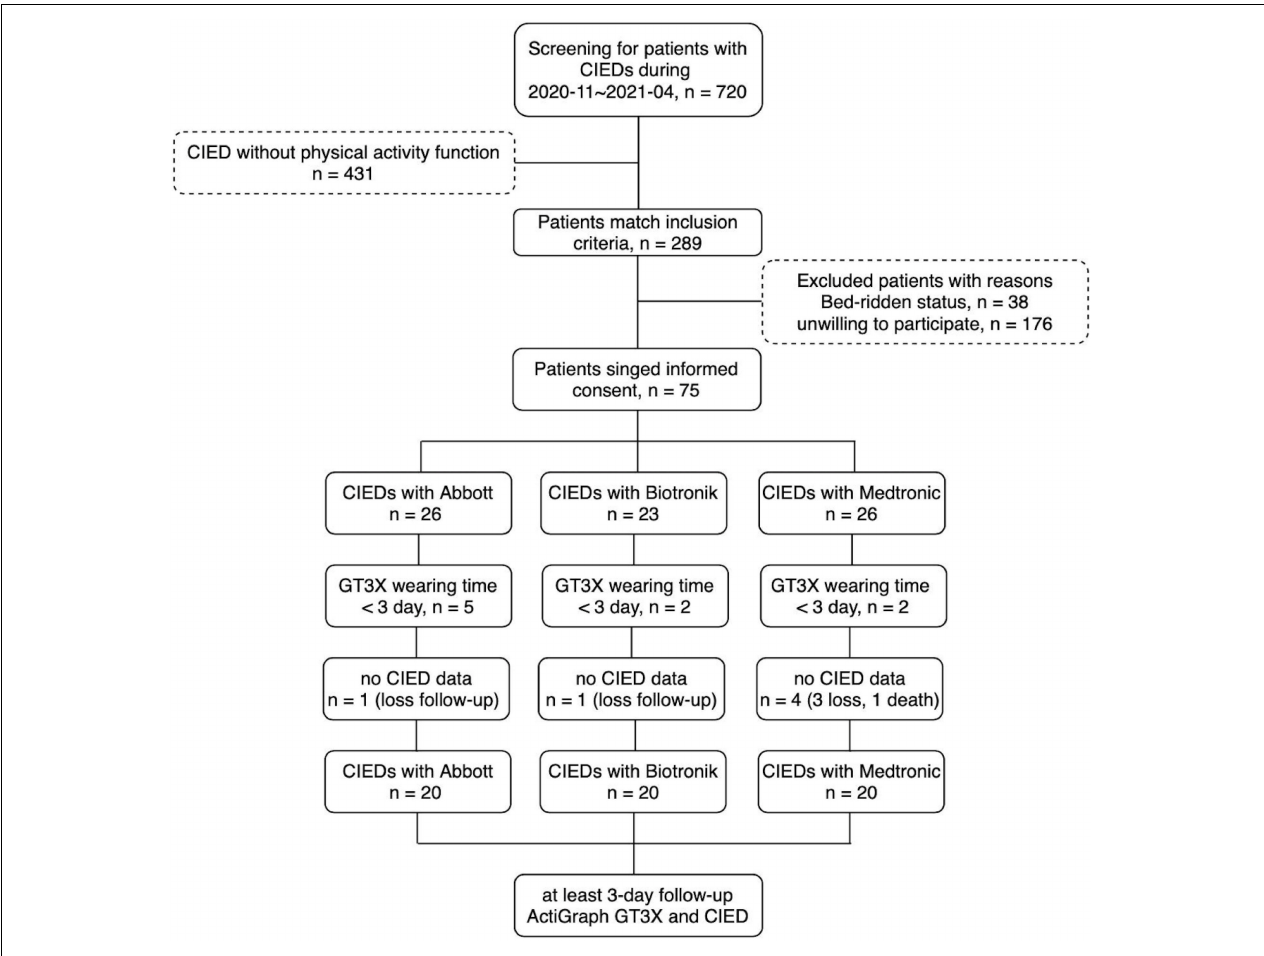
FIGURE 1 | Study flow